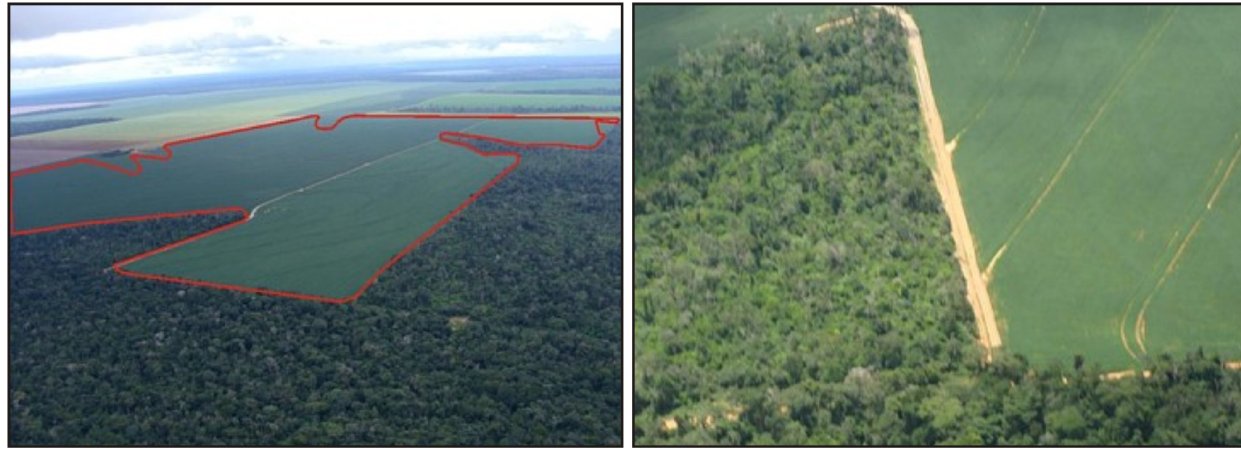
Figure 5. Oblique aerial photographs showing a soybean field in a deforested